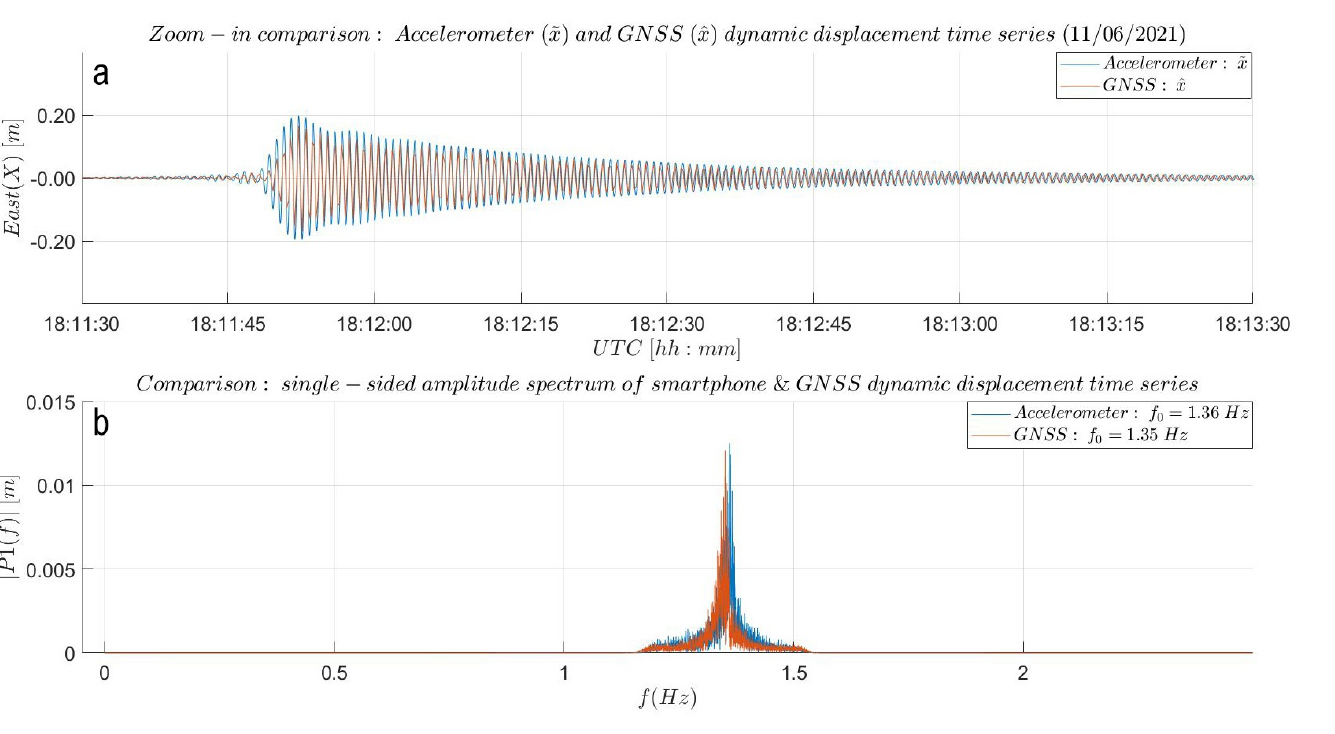
Figure 9. AID experiment results: ( a ) Zoom-in into Figure A7. Overlap of dynamic displacements. Smartphone accelerome- ter time series was shifted by 47.93 s to the right. Additionally, from the beginning of vibrations, the time series was shifted by 0.01 s to the right to compensate for the smartphone oscillator in stability. The good match in amplitude and phase s attests the capability of the low-cost GNSS instrument of dynamic deformation monitoring. Note the warming up effect of both displacement time series produced by the transient response of the IIR filtering process. Instead of this, a sudden ’pull’ to maximum was expected. ( b ) Natural frequency match without prior time correction. The identified natural frequency of the CB is of 1.36